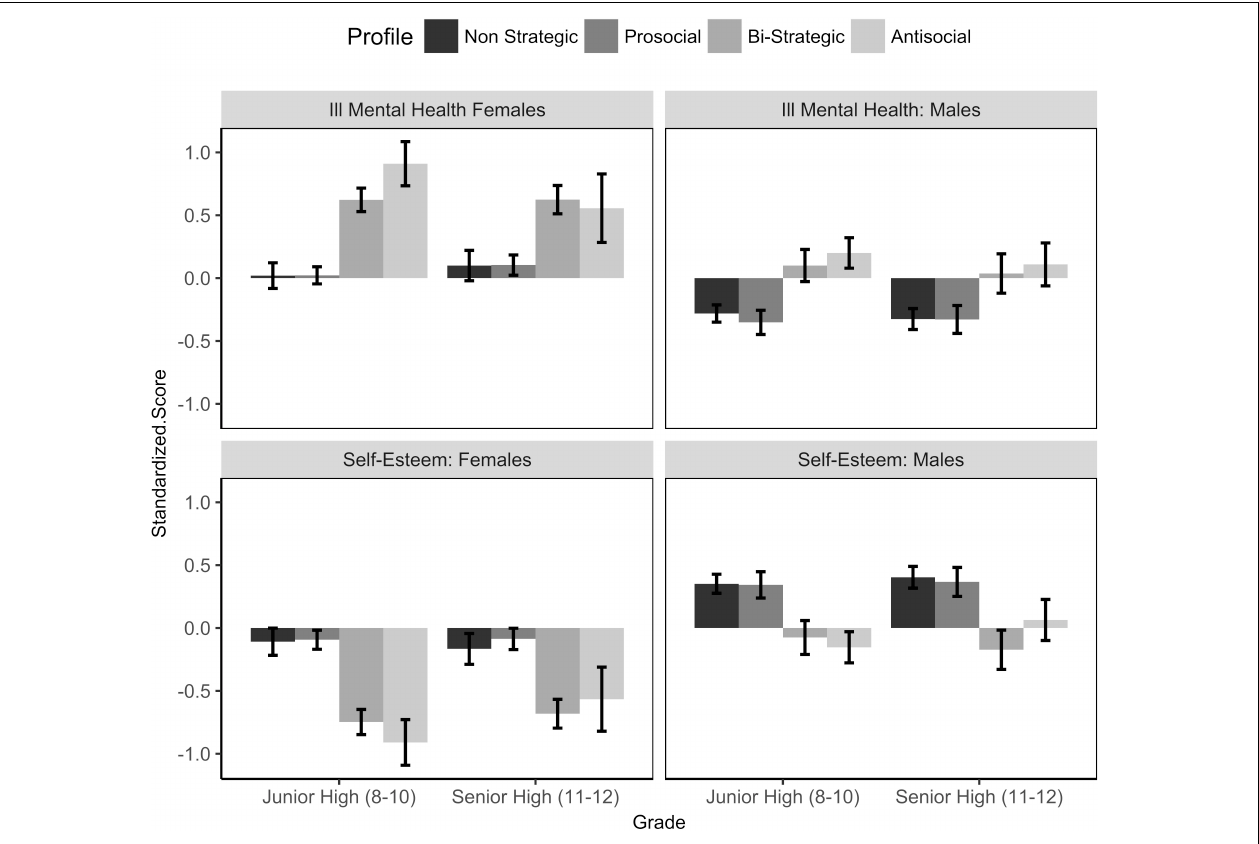
FIGURE 3 | Mental Health and Self-Esteem broken down by Profile and Gender. Error bars represent 95% confidence